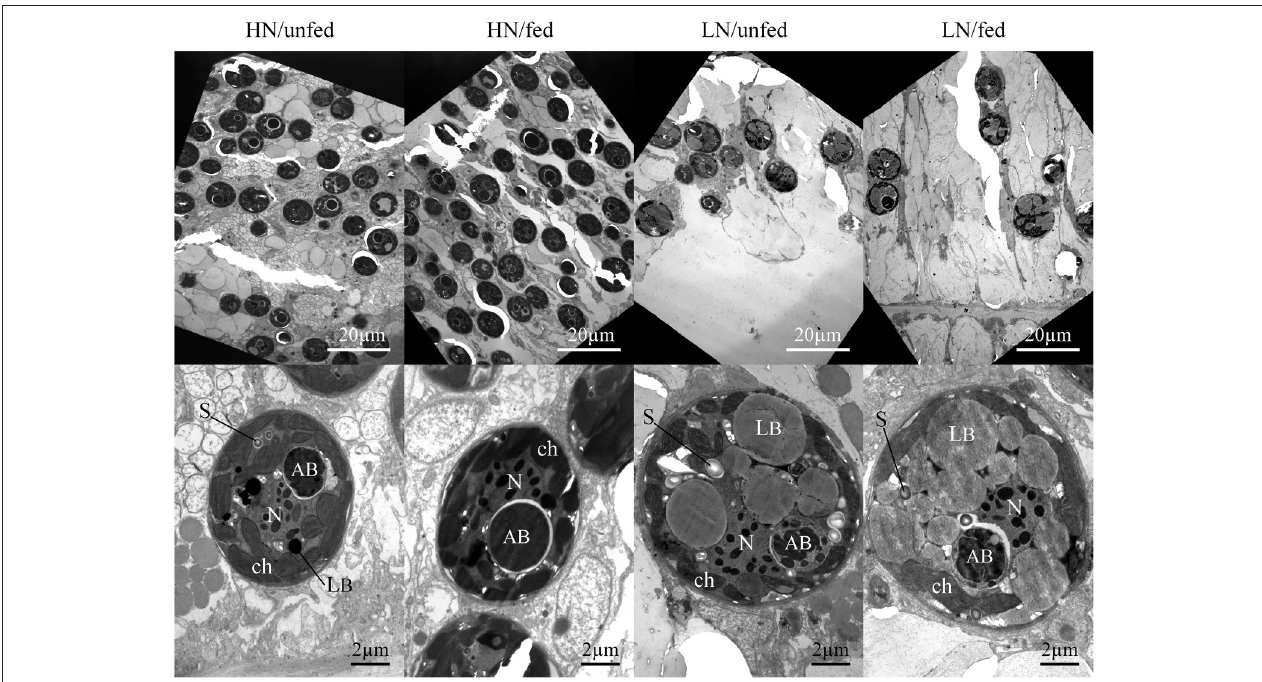
FIGURE 2 | Effects of the dissolved inorganic nutrient concentration and heterotrophic feeding on zooxanthellae population density and ultrastructure in hospite . Representative micrographs of tentacle sections showing the zooxanthellae population within the host endoderm (magnification x1000, top panels) and zooxanthellae cell sections representing the mean ultrastructure resulting from each nutrient treatment (magnification x6000, lower panels). AB, accumulation body; ch, chloroplast; LB, lipid body; N, nucleus with condensed chromosomes; P, pyrenoid; S, starch